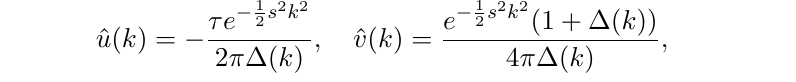
and z under the map (3.11), while 0 ±